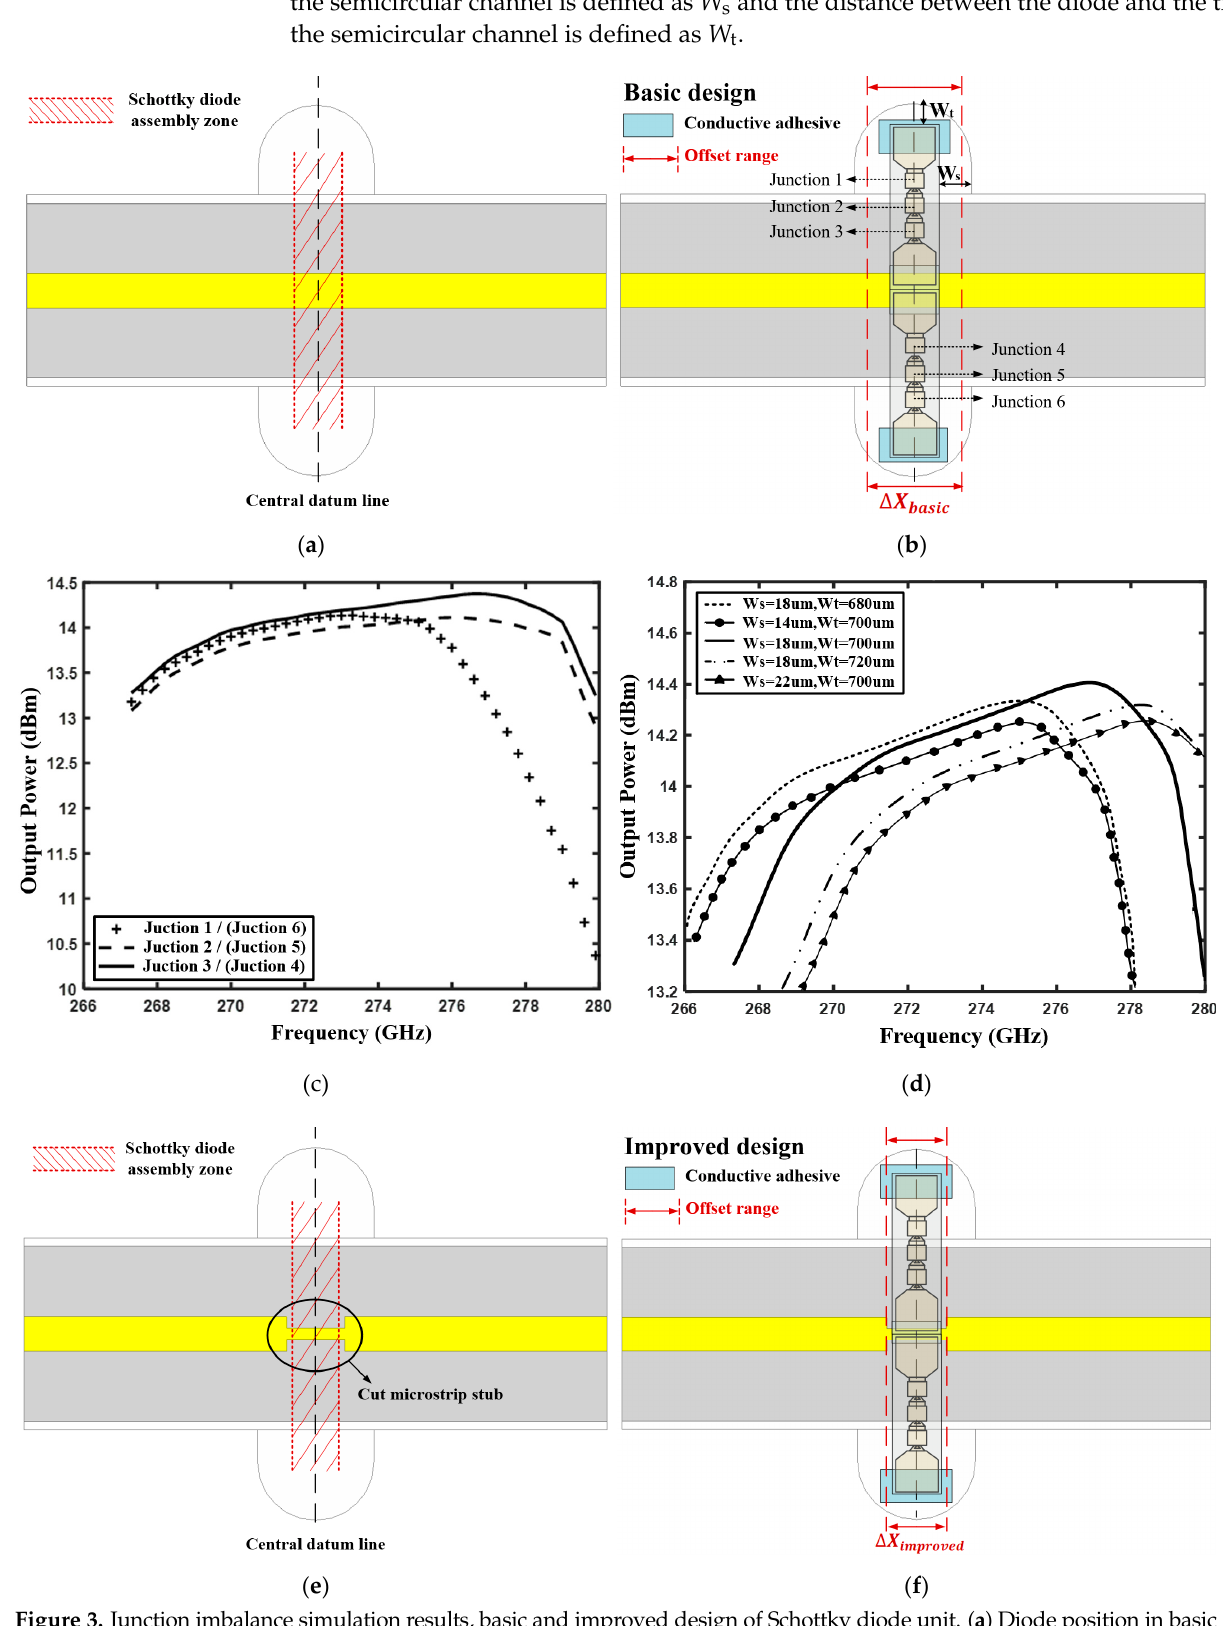
Figure 3. Junction imbalance simulation results, basic and improved design of Schottky diode unit. ( a ) Diode position in basic design; ( b ) Diode unit structure in basic design; ( c ) Output power imbalance of the 3rd harmonics at different junctions; ( d ) Output power vs. W s / W t (at fixed junction); ( e ) Diode position in improved design; and ( f ) Diode unit structure in improved design.